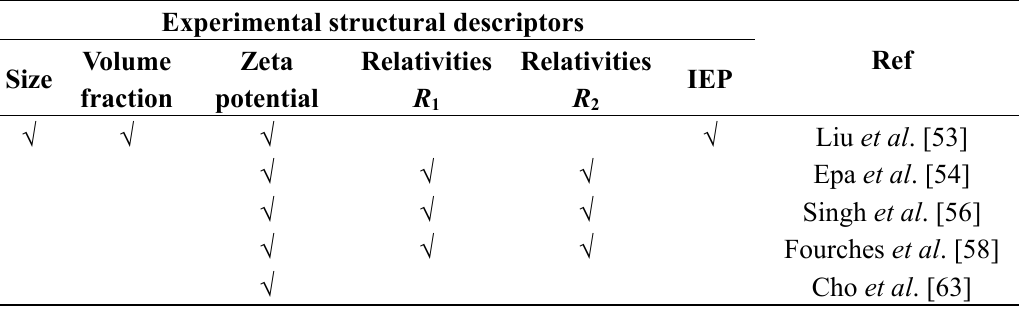
Table 2. Main experimental structural descriptors used in some metal oxide (Q)NAR